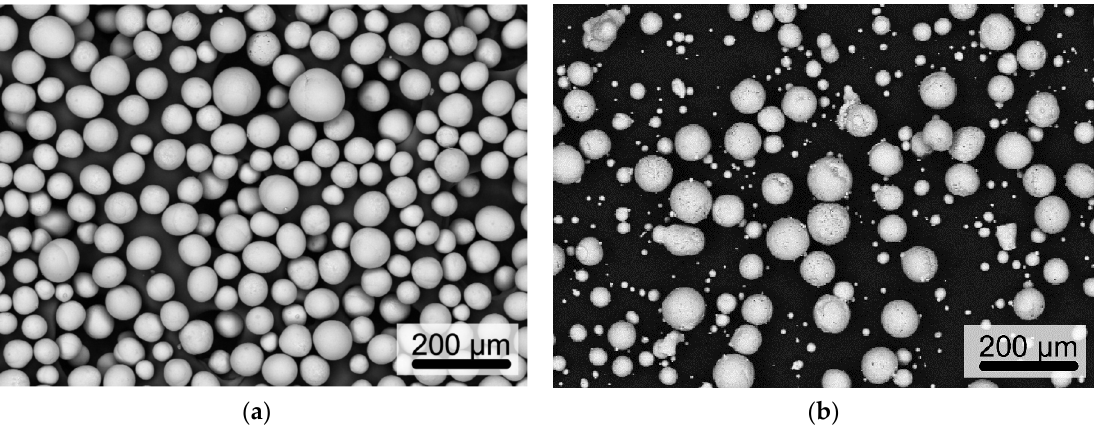
Figure 2. SEM BSE topography images of UA powder particles ( a ) and EIGA powder particles ( b ).